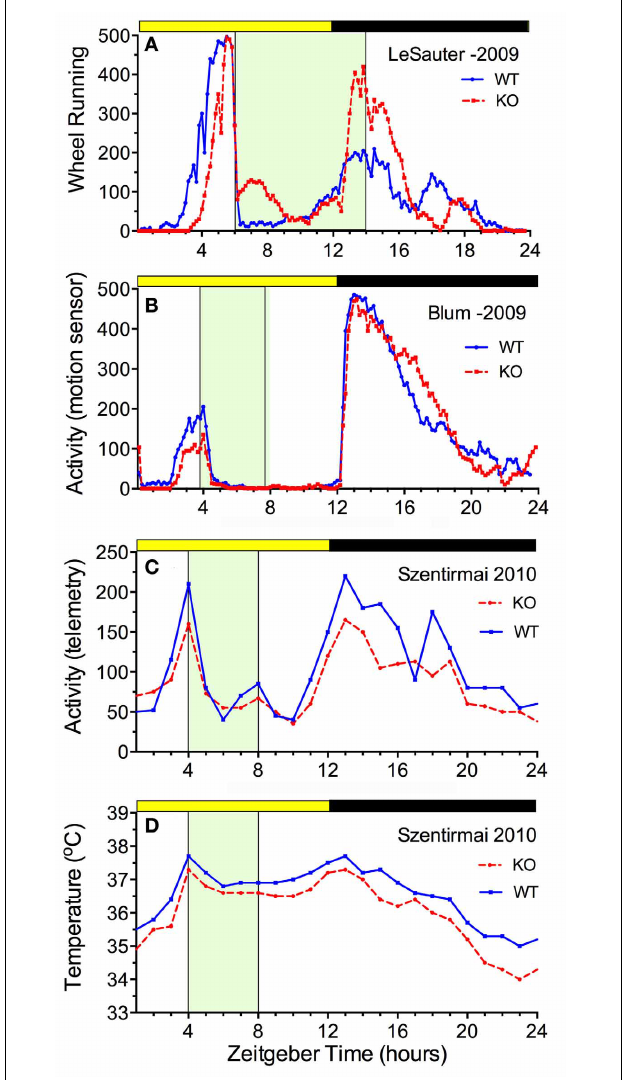
FIGURE 3 | Average waves illustrating the consequences of ghrelin receptor knockout (A,B) and preproghrelin KO (C,D) on food-entrained locomotor activity and body temperature in mice. Knockout groups are represented by the red dashed lines, WT by the solid blue lines. (A) The onset of wheel running activity is modestly delayed in ghrelin receptor knockout mice, but rises to the same level (LeSauter et al., 2009). (B) The onset of running is not delayed but rises to a lower level in ghrelin receptor knockout mice (Blum et al., 2009). (C) Locomotor activity measured by telemetry is slightly reduced at all time points in preproghrelin KO mice compared to WT mice, but increases equivalently prior to a 4-h daily meal in both groups (Szentirmai et al., 2010). (D) The same results were obtained for core body temperature measured by telemetry (Szentirmai et al.,